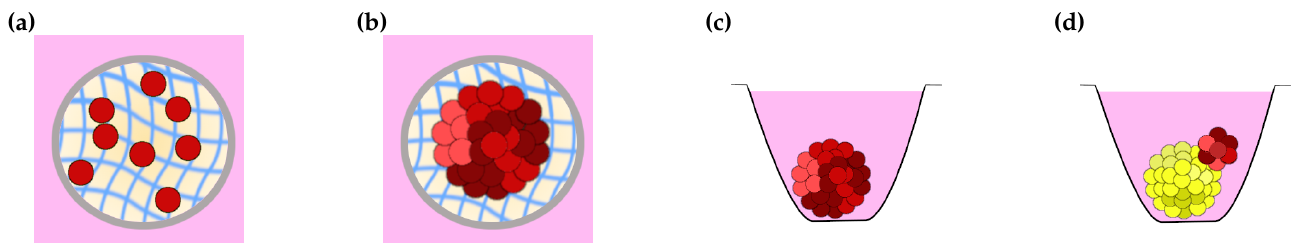
Figure 1. Schematics depicting various key culture modalities employed to model HGG. ( a ) matrix-supported cell suspen- sion, ( b ) matrix-supported glioma spheroid (GS) or tumouroid (GT), ( c ) free spheroid and ( d ) free organoid/tumouroid (BO/GT) or organoid/spheroid (BO/GS) co-culture.